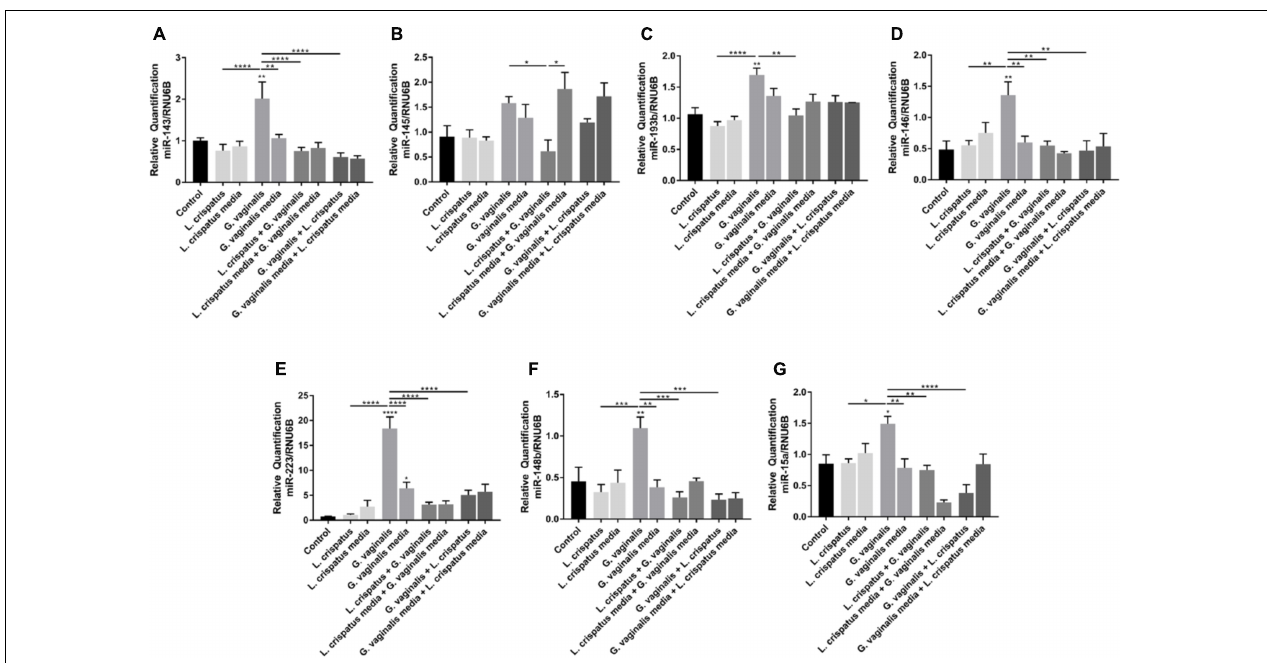
FIGURE 6 | Lactobacillus crispatus bacteria-free supernatants mitigate the G. vaginalis -induced miRNA expression profile in ectocervical cells. miRNA expression (A–G) was measured by QPCR in ectocervical cells after exposure to L. crispatus supernatants (5% v/v) on day 1 followed by G. vaginalis supernatants (5% v/v) on day 2 or vice versa for 24–48 h. Bacterial growth media alone acted as a negative control for the three bacteria-free supernatants tested. The (cid:49)(cid:49) CT method was used for relative expression quantification using the endogenous reference gene RNU6B. Values are mean ± SEM. Asterisks over the individual bars represent comparisons to control; asterisks over solid lines represent comparisons between treatment groups. ∗ p < 0.05, ∗∗ p < 0.01, ∗∗∗ p < 0.001, ∗∗∗∗ p <